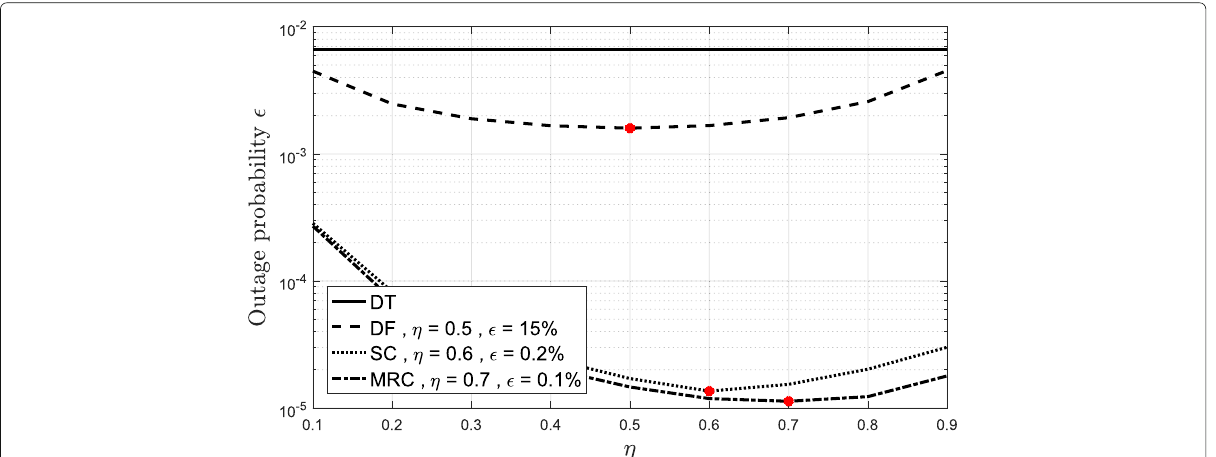
Fig. 5 Impact of power allocation factor η on the outage probability with k = 250. This figure illustrates the optimal value of power allocation factor for each of studied relaying scenarios where the outage probability is minimized. We show that we have to allocate more power to the source to work in ultra-reliable region and MRC requires more power at the source compared to the other studied protocols